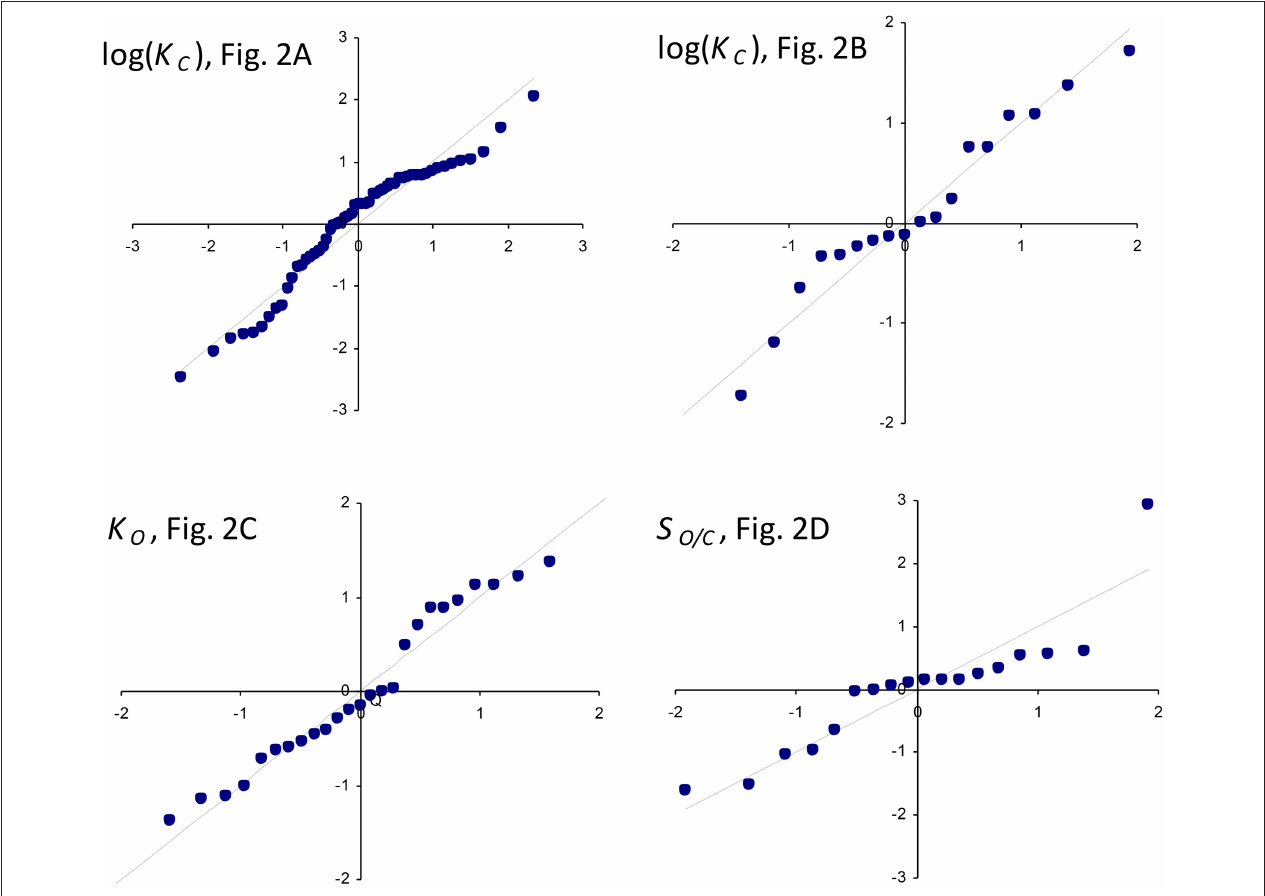
K C ( Figures 2A,B ), K O ( Figure 2C ), and the reciprocal relative specificity, S O / C = 1 S (cid:0) (cid:1)